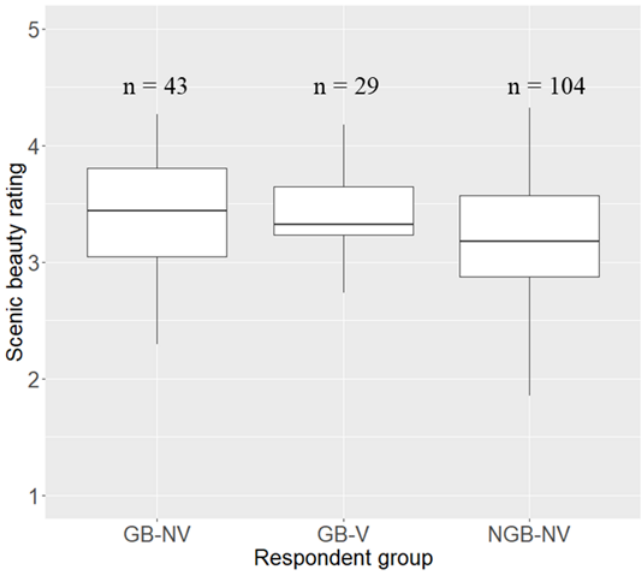
Figure 3. Boxplot of mean scenic beauty ratings of the 34 geosites by respondents, grouped following their geoscience background and field visits: NGB-NV = no geoscience background and no visit to geosites; GB-NV = geoscience background and no visit to geosites; GB-V = geoscience background and visit to geosites; n = the number of respondents in each group; scenic beauty was rated on a 1–5